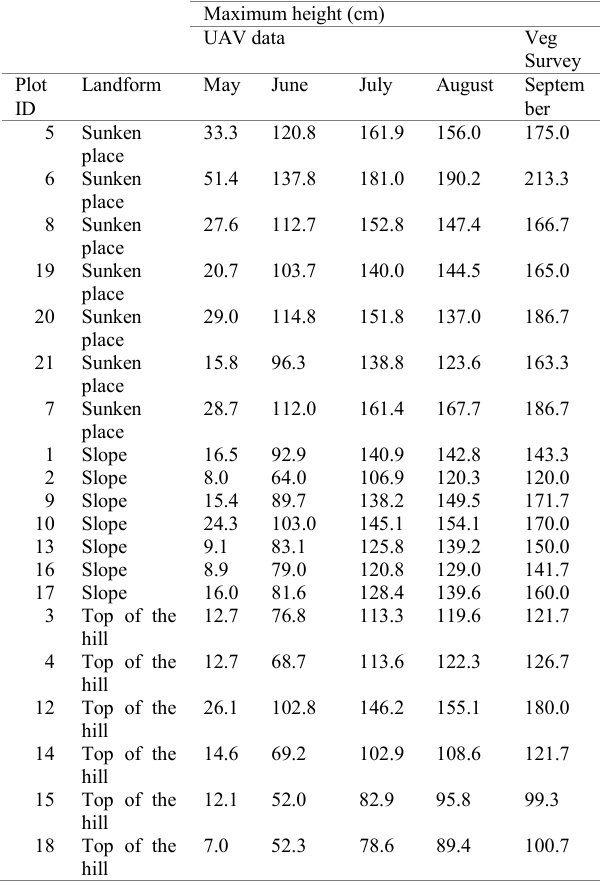
Table 1. Maximum height of M. sinensis in each plot derived